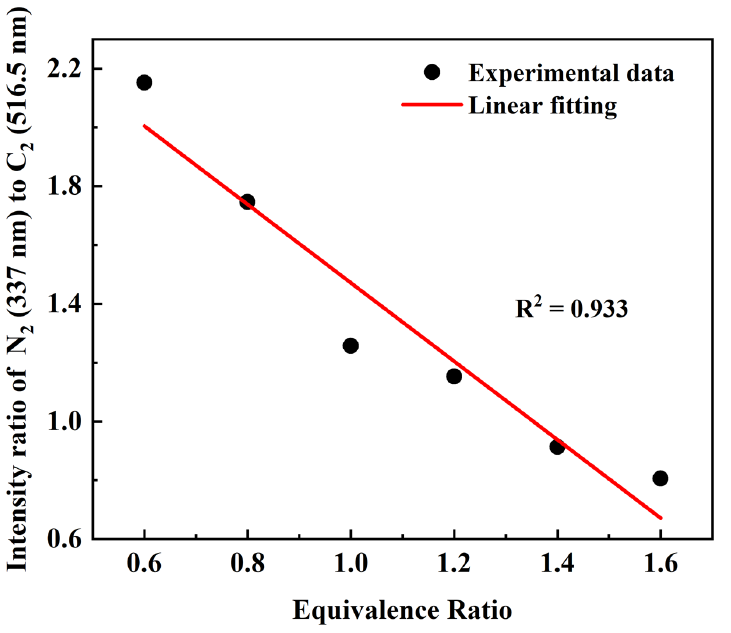
Figure 5. Calibration curve of signal intensity ratio of N 2 (337 nm) and C 2 (516.5 nm) as a function of equivalence ratio.